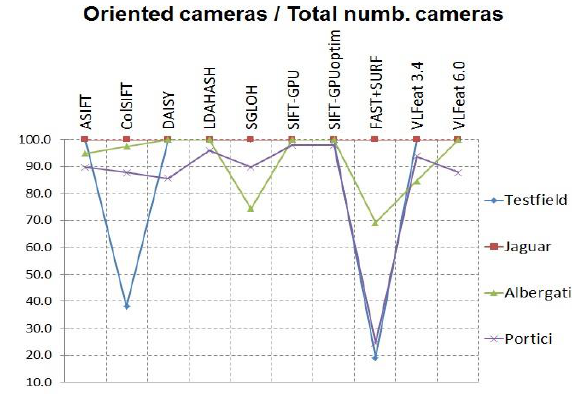
Figure 3: Percentage of oriented cameras for each dataset and feature- based method. - root mean square error of the bundle adjustment (Fig. 4): it expresses the re-projection error of all computed 3D points. ASIFT and SIFT-GPU have limited results in all the datasets (last one probably due to changes in the parameter values